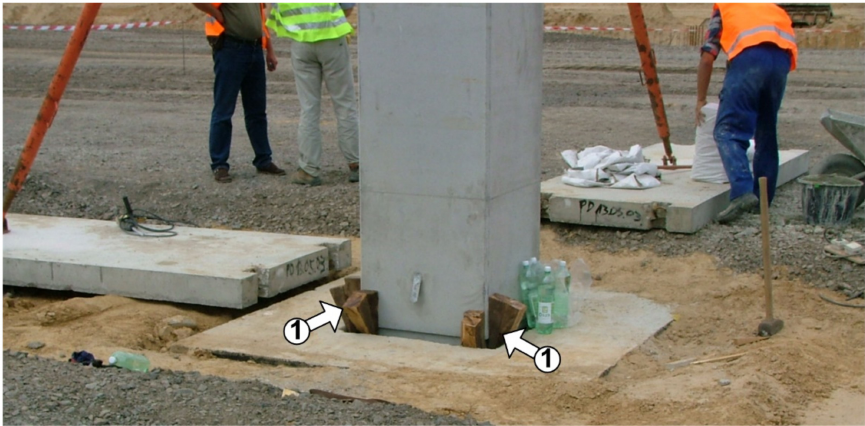
Figure 12. View of the wedged column after assembly in the pocket; 1—special oak wedges.